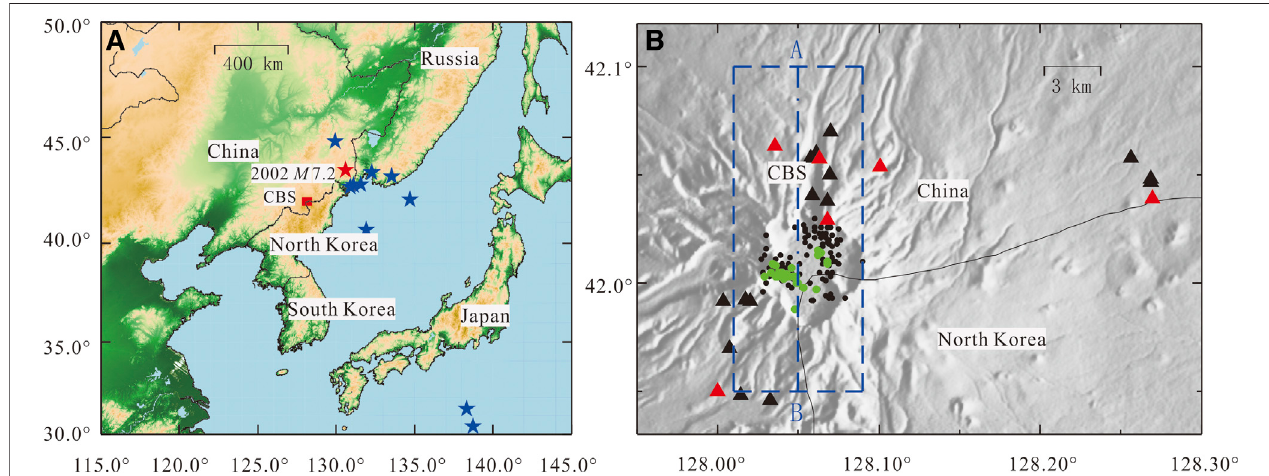
FIGURE 1 | (A) Map showing the location of Changbaishan volcano in East Asia. The red star marks the location of the 2002 M 7.2 Wangqing earthquake. Blue stars mark other deep-focus earthquakes in thisregion. The blue triangles indicate theJEA cataloguestations, and thered boxmarksthe location oftheenlarged plot in (B) . (B) Distribution of seismic stations and different types of seismic events during the volcanic unrest period. The red triangles mark stations used to build the CHVO catalogue, the black triangles indicate stations for the Wu catalogue, the black dots indicate VT events, and the green dots indicate HS